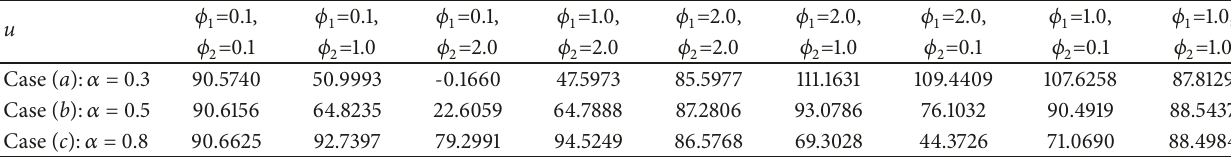
Table 8: The impact of fairness concern on the total expected utility u under three